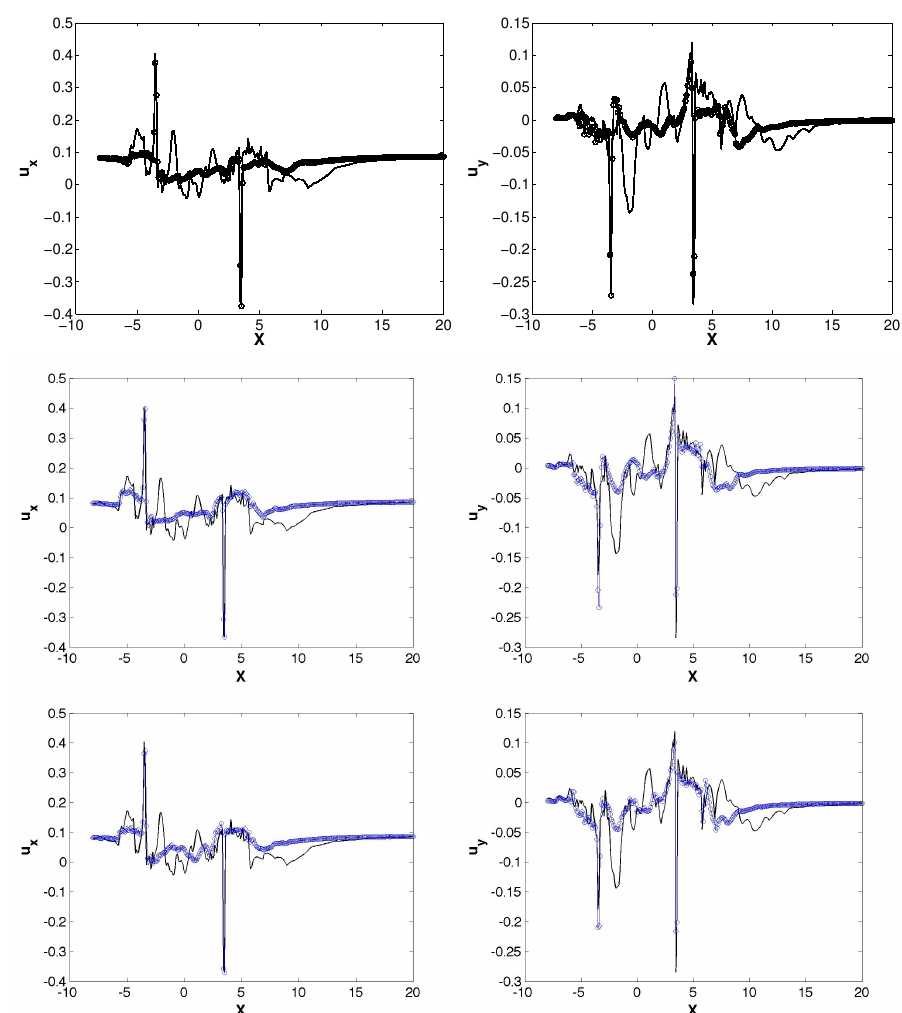
Figure 13. Counterpart of Figure 7 in the three-blades turbine applying HODMD in 196 snapshots starting at time 80.1s. Data extracted at y = 2